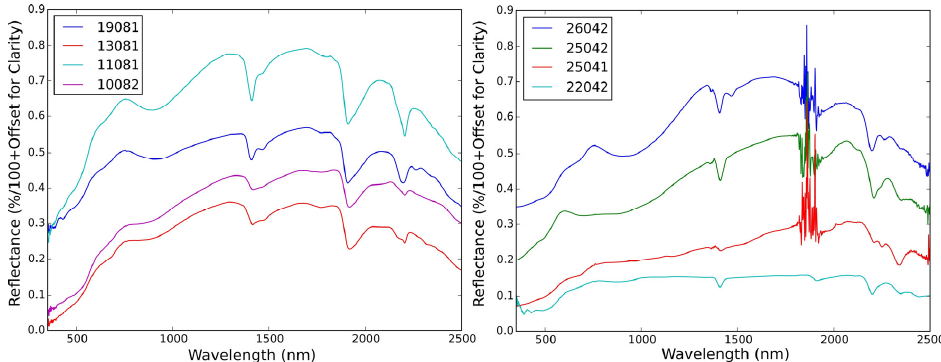
Figure 3. PSF weighted field spectra from test sites from the Rodalquilar caldera ( left ) and the Haib river deposit ( right ). Contact probe PSF spectra are the smooth spectra.